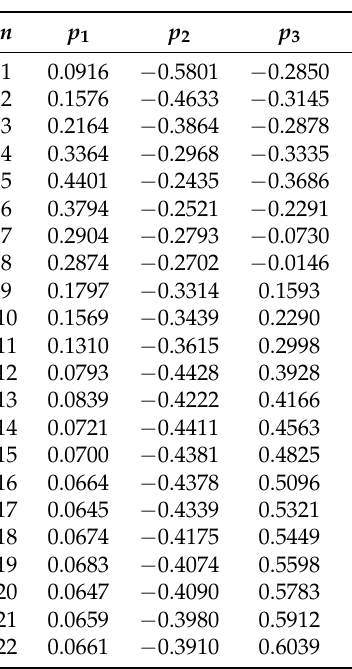
Table C1. The coefficients for the fitting function of µ against P f , ILS : f µ ( x ) = p 1 x p 2 + p 3 . The tolerable = failure rate is P tol f